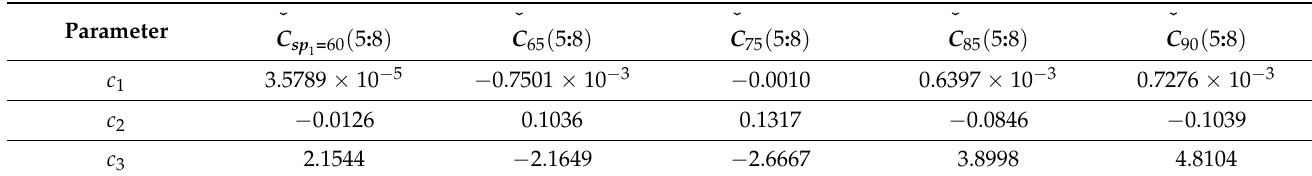
( 5 : 8 ) parameters’ values (procedure 6). 1